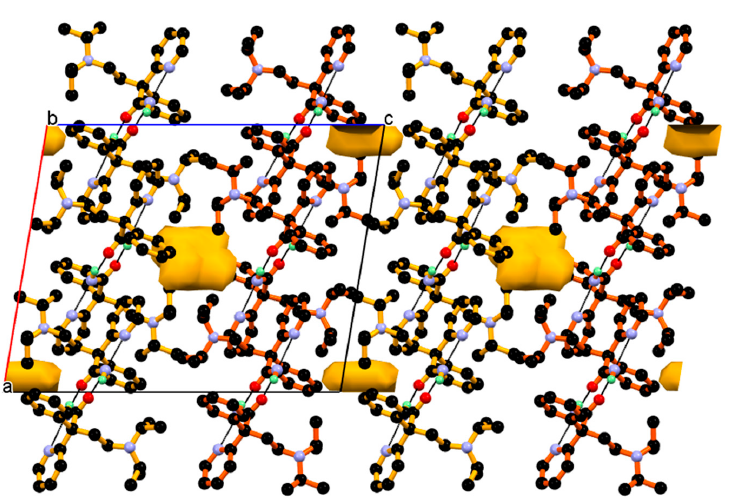
Figure 6. Neighboring 2-dimensional network of dimeric units of DPA assembled loosely via relatively weak non-covalent interaction and hydrophobic forces along the c -axis, resulting in 3- dimensional packing; such packing creates a solvent accessible void between